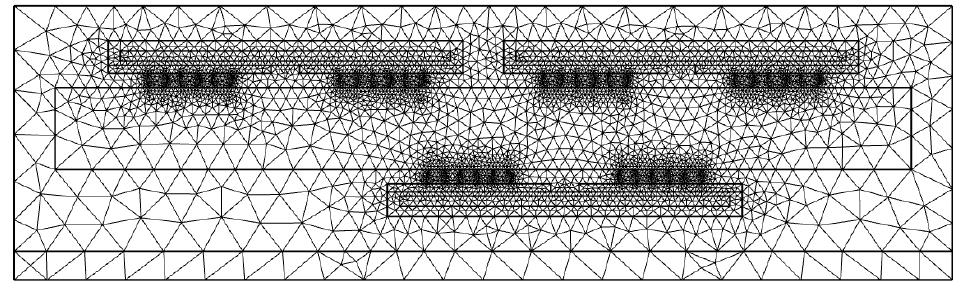
Figure 4. Meshing of 3D packaging memory.